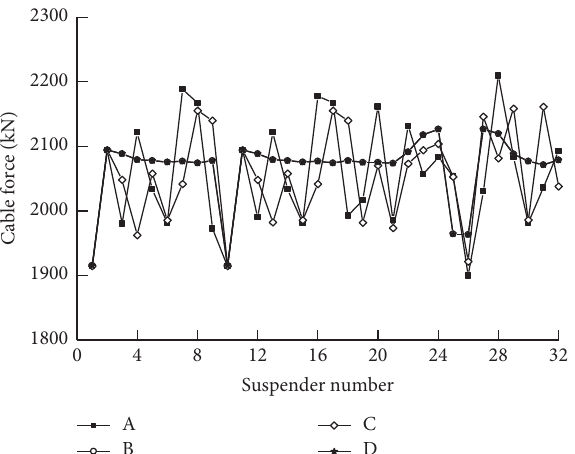
Figure 5: Completion cable force after adjustment. (A: cable force measured before upstream adjustment; B: upstream target value; C: measured cable force after downstream adjustment; D: downstream target value).